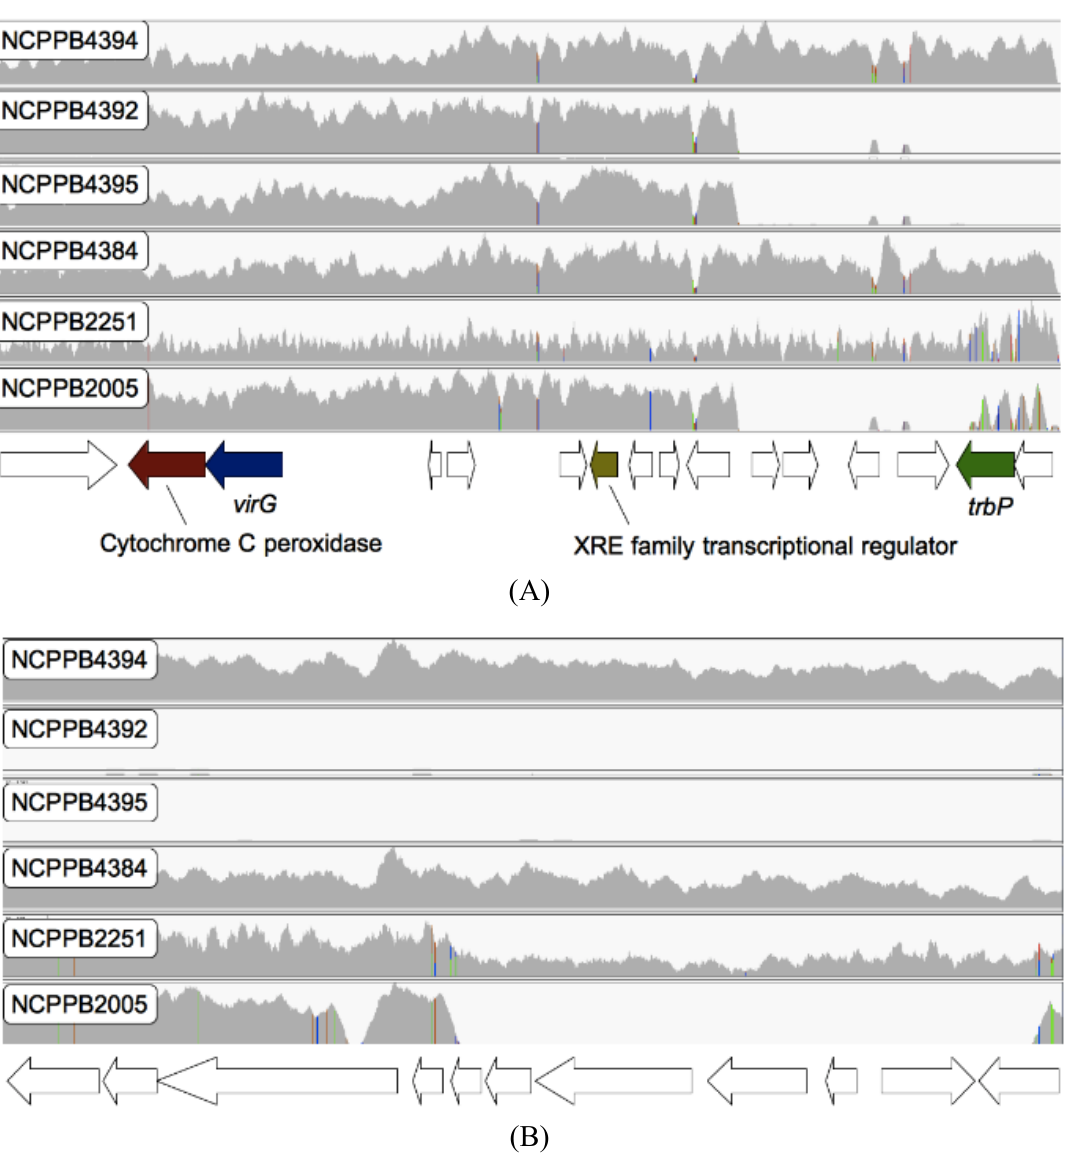
Figure 4. Loss of phage-related genes in two Tanzanian isolates and one Ethiopian isolate of Xcm . The figure shows alignments of genomic sequence reads from six Xcm isolates versus two contigs from the previously published NCPPB4381 genome assembly [12] as viewed in IGV. ( Panel A ): contig_scf_7264_3425_27 (GenBank: ACHT01000345.1); ( Panel B ): contig_scf_7264_3425_29 (GenBank: ACHT01000346.1). Both contigs are contained within genomic scaffold scf_7264_3425 (GenBank: GG699410.1). The vertical axes are the depth of coverage by aligned sequence reads. Coloured vertical bars indicate discrepancies with the NCPPB4381 reference sequence, including SNPs. The horizontal axis is the position on the contig. Positions of predicted genes are indicated below the horizontal axis. Hypothetical genes of unknown function are indicated by white arrows while homologues of characterized genes are indicated by coloured